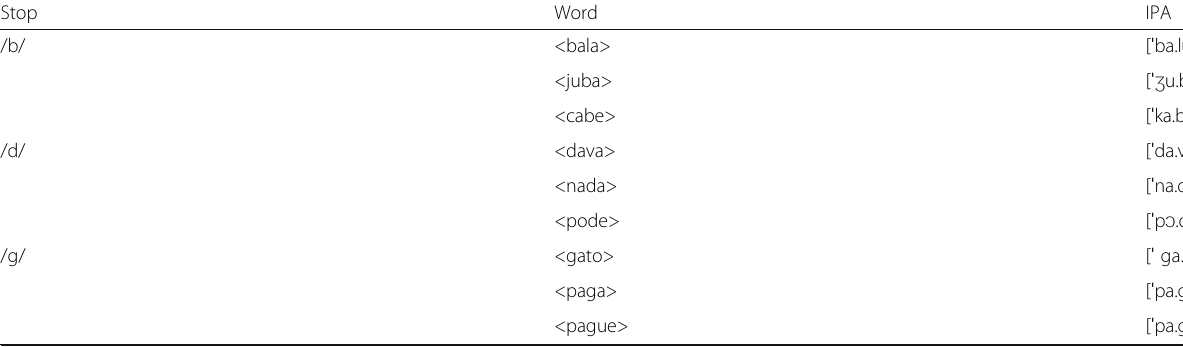
Table 14 Corpus of voiced stops: words without a frame sentence